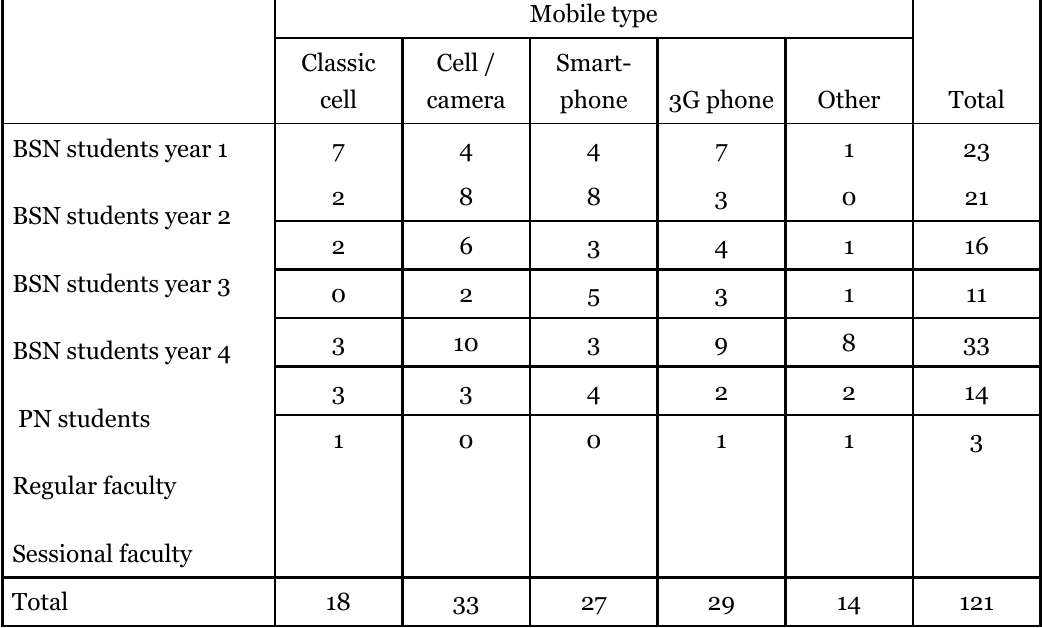
Mobile type TotalClassic Cell / Smart - cell camera